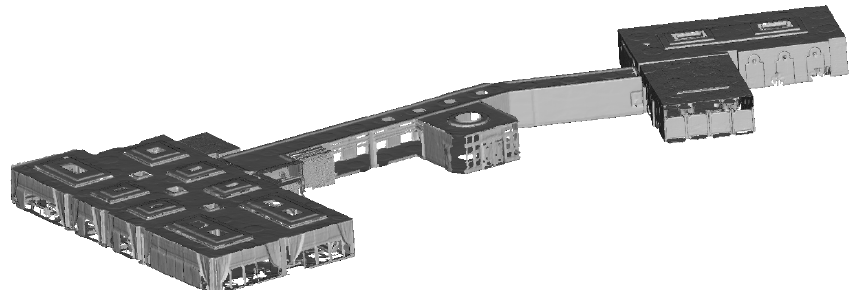
Figure 22. Detailed view of the triangle mesh “PuKPg4mmafe” from the Matterport3D dataset also depicted in Figures 15h and 21. Note that in the case of the larger part of the building structure determining the Manhattan World system visualized by the red bounding box in Figure 21, large parts of the wall surfaces are missing as wall openings or constituted by curtains or other structures with inhomogeneous normal direction. The smaller part of the building structure on the right-hand side, which determines the Manhattan World system visualized by the green bounding box in Figure 21, however, has largely closed, smooth wall